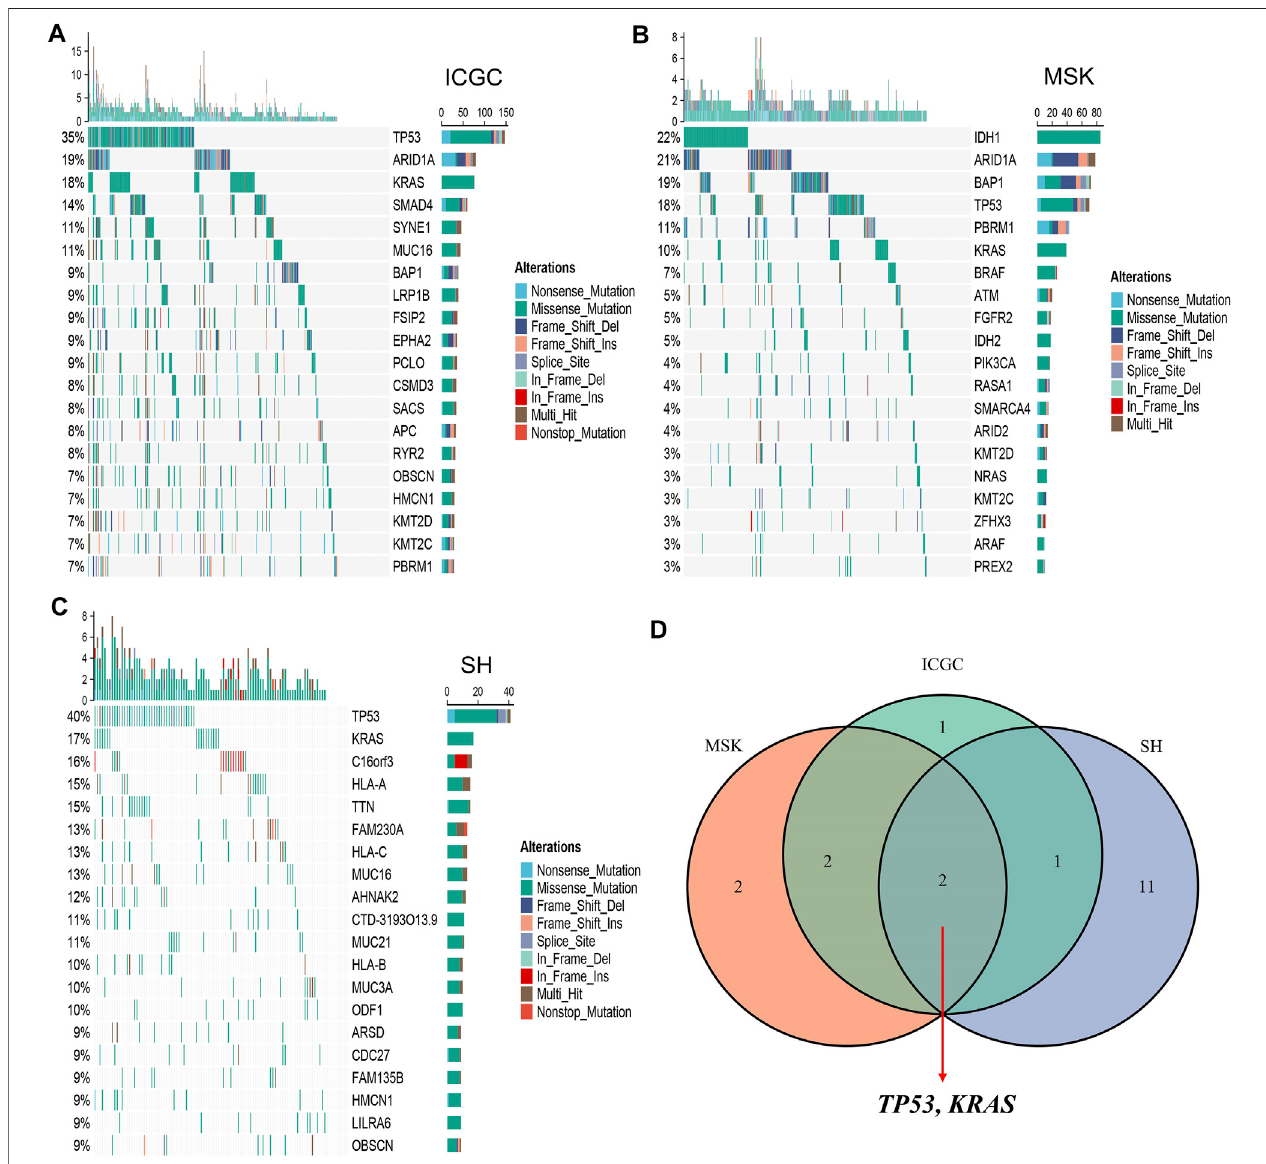
FIGURE1| Landscapesofhigh-frequencymutatedgenes(FMGs)inintrahepatic cholangiocarcinoma(ICC). (A – C) Oncoplotdepicts theFMGsofICCintheICGC (A) , MSK (B) , and Shanghai (C) cohorts. (D) Venn diagram of FMGs covered by the three large-scale cohorts.